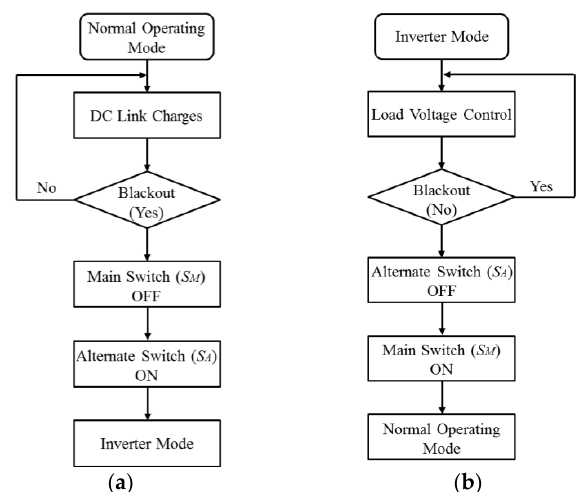
Figure 3. Flowchart for the ( a ) normal operating; and ( b ) inverter modes of the conventional offline UPS system.